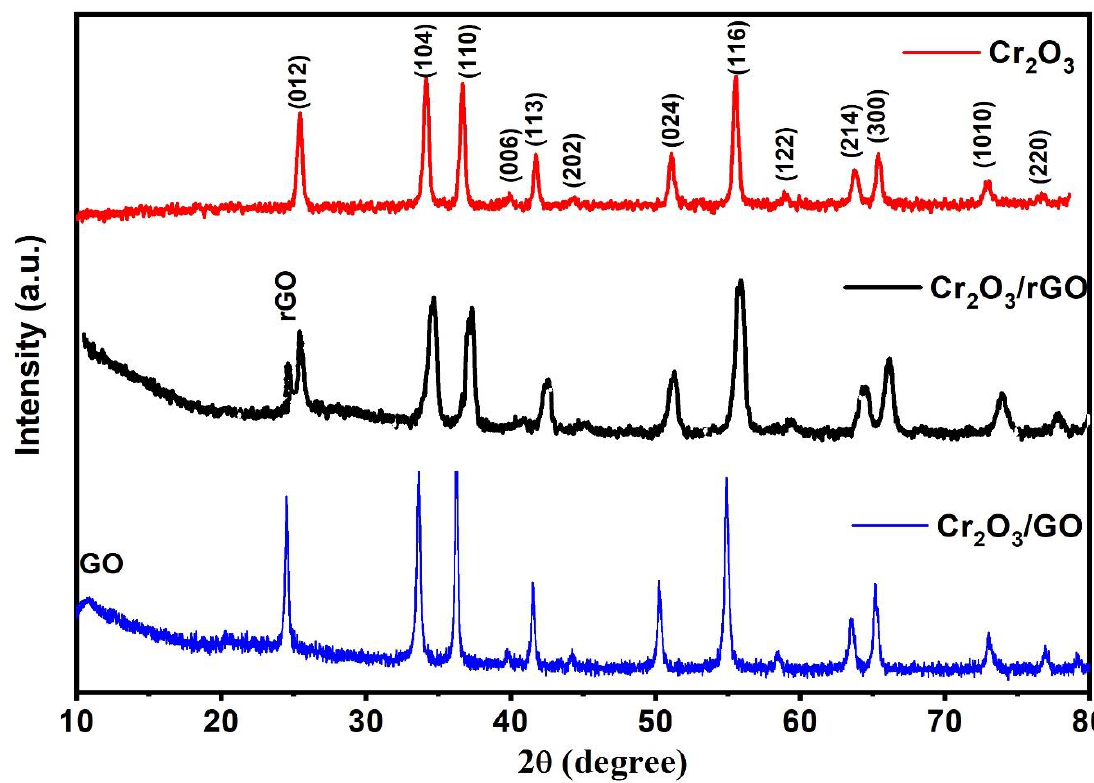
Figure 3. XRD patterns obtained for the bare α-Cr 2 O 3 NPs and the hybrids Cr 2 O 3 /rGO and Cr 2 O 3